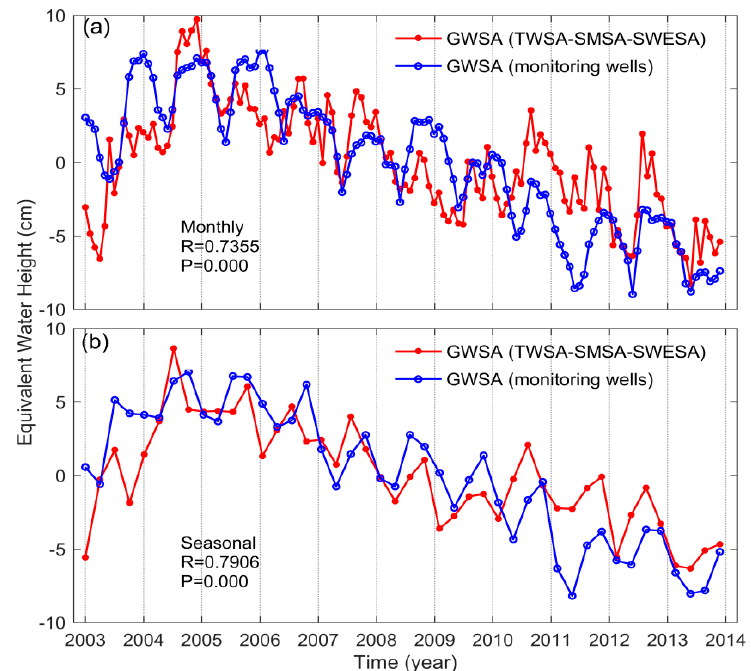
Figure 3. ( a ) Monthly and ( b ) seasonal variations between GRACE-derived GWSA and monitoring well observations in the 3H Plain.